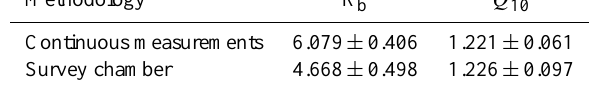
Table 3. Parameters of the Q 10 model fitted for the contemporary measurements of soil respiration obtained by the multiplexed sys- tem and the survey chamber system. Methodology R b Q 10 Continuous measurements 6.079 ±